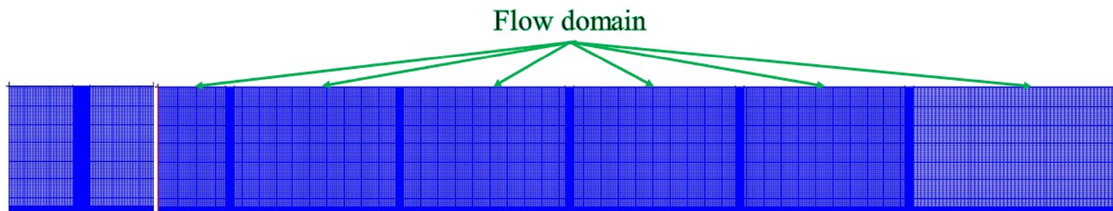
Figure 1. Computational domain and boundary conditions.